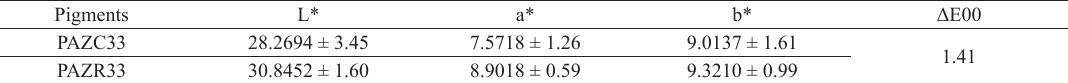
Table 2. CIE L*a*b* colorimetric coordinates of powder pigments PAZC33 and PAZR33. The samples were synthesized in triplicates. Pigments L* a*